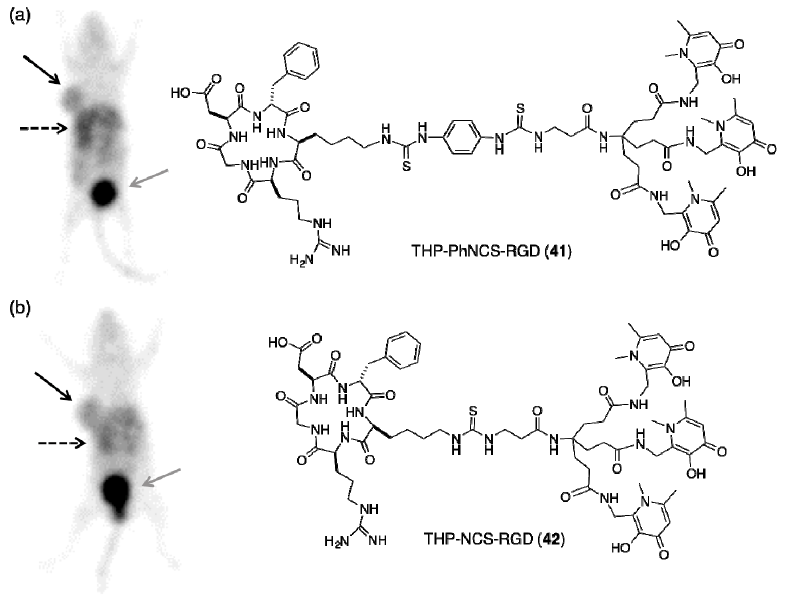
Figure 11. Representative PET maximum intensity projection of Balb/c nu/nu mice bearing U87MG tumours on right flank at 1 h post-injection of: ( a ) [ 68 Ga(THP-Ph-NCS-RGD)]; and ( b ) [ 68 Ga(THP-NCS-RGD)]. Black arrow, tumour; grey arrow, bladder; dashed arrow, kidneys and liver.